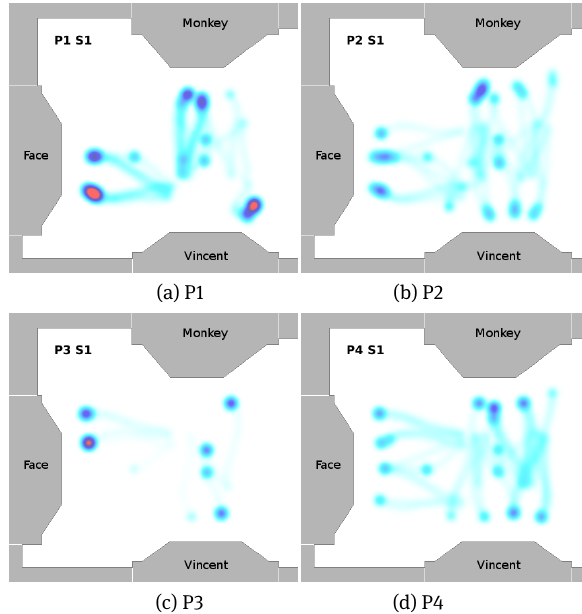
Fig. 10. Heatmap of the robot’s movements within each exhibit area during the first in-robot gallery visitation (S1) for each participant; movement between exhibits is not shown. In each image, the Face exhibit is the leftmost, then the Monkey and Vincent exhibits mov- ing in the clockwise direction. The heatmaps depict the amount of time the robot spent moving within each exhibit area, specifically from an exhibit’s main entry pose and its 4 hotspots ( left , center , right , and info